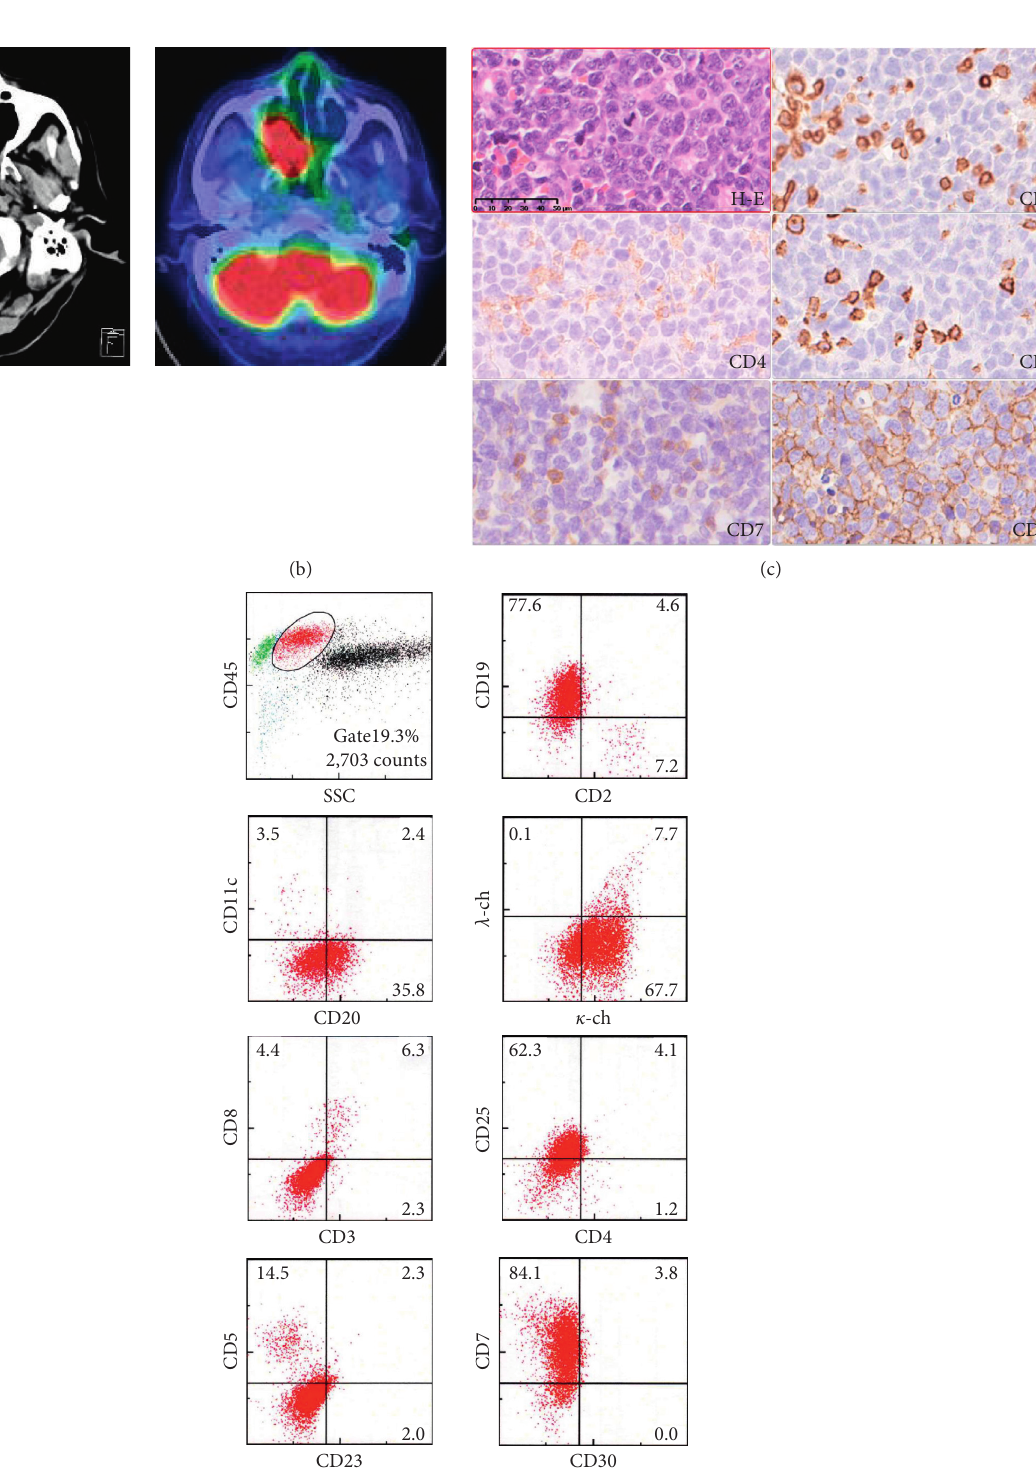
Figure 1: Imaging findings: (a) brain computed tomography scan at diagnosis; (b) positron emission tomography-computed tomography findings at diagnosis; (c) pathological findings at diagnosis (hematoxylin and eosin staining) and immunostaining with anti-CD3, anti-CD4, anti-CD8, anti-CD7, and anti-CD20; (d) flow cytometry analysis at